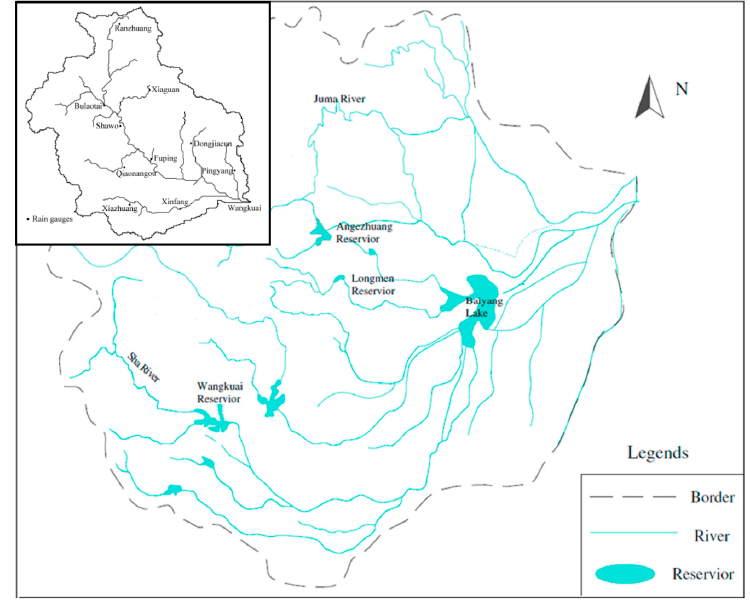
Figure 1. The study area: Wangkuai Reservoir in the Daqinghe river basin with the Wangkuai Reservoir watershed in the upper-left corner.